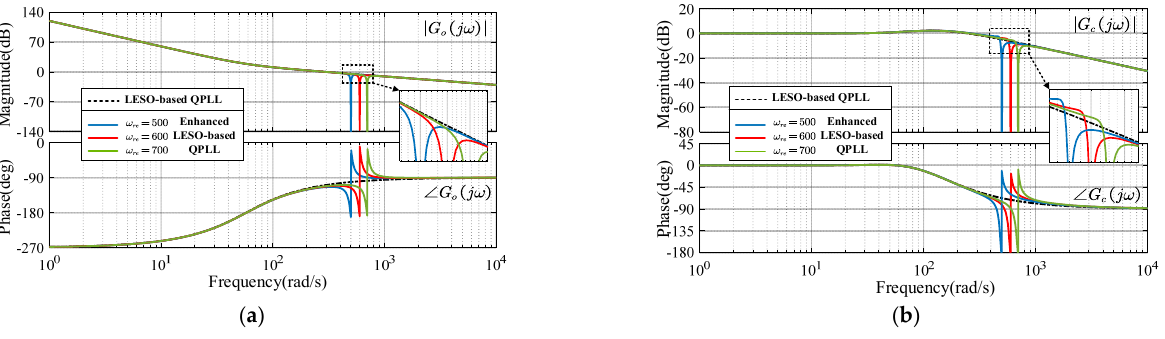
( ) G s under different o